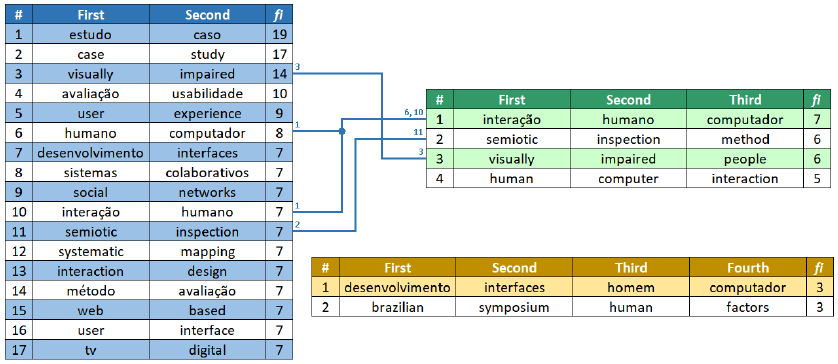
Figure 12. n -grams correlation network from IHC: (a) bigram; (b) trigram; (c) quadgram.